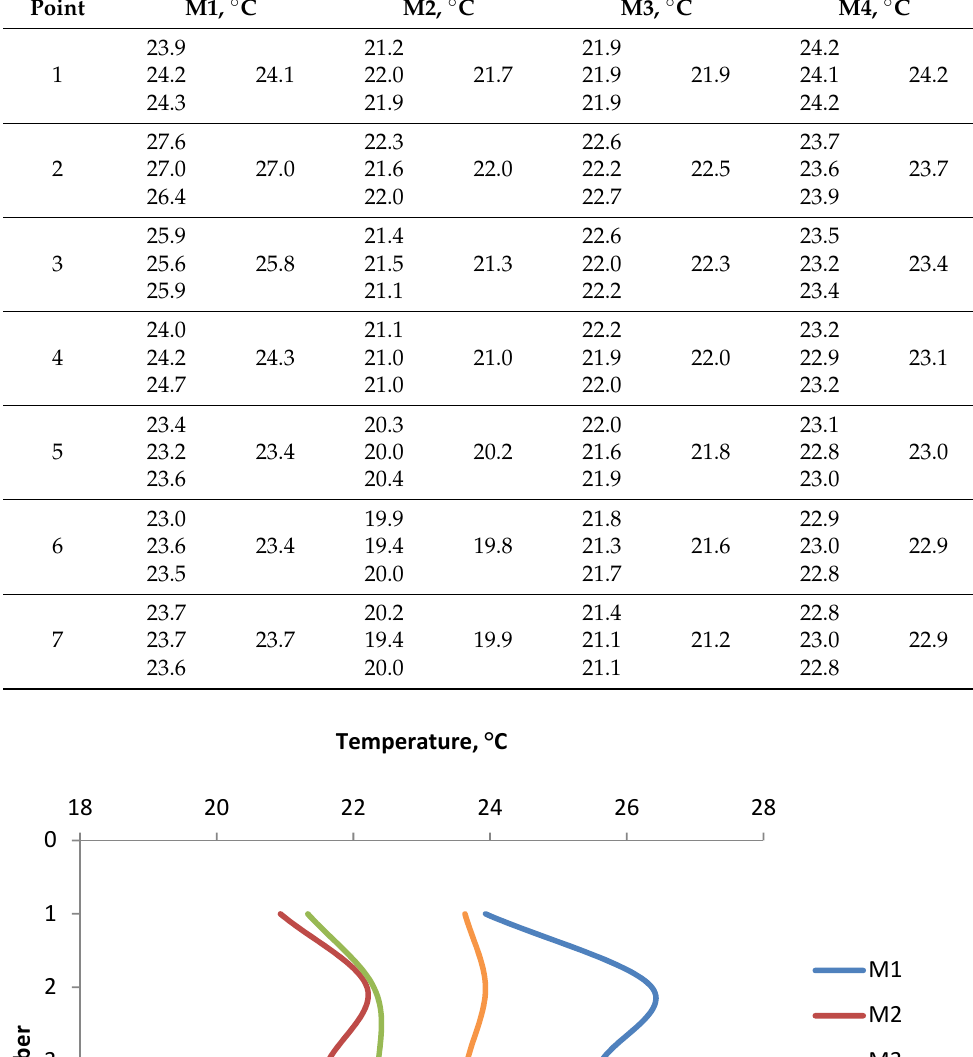
Table 4. The temperature distribution on the back side briquette surfaces in the characteristic points.